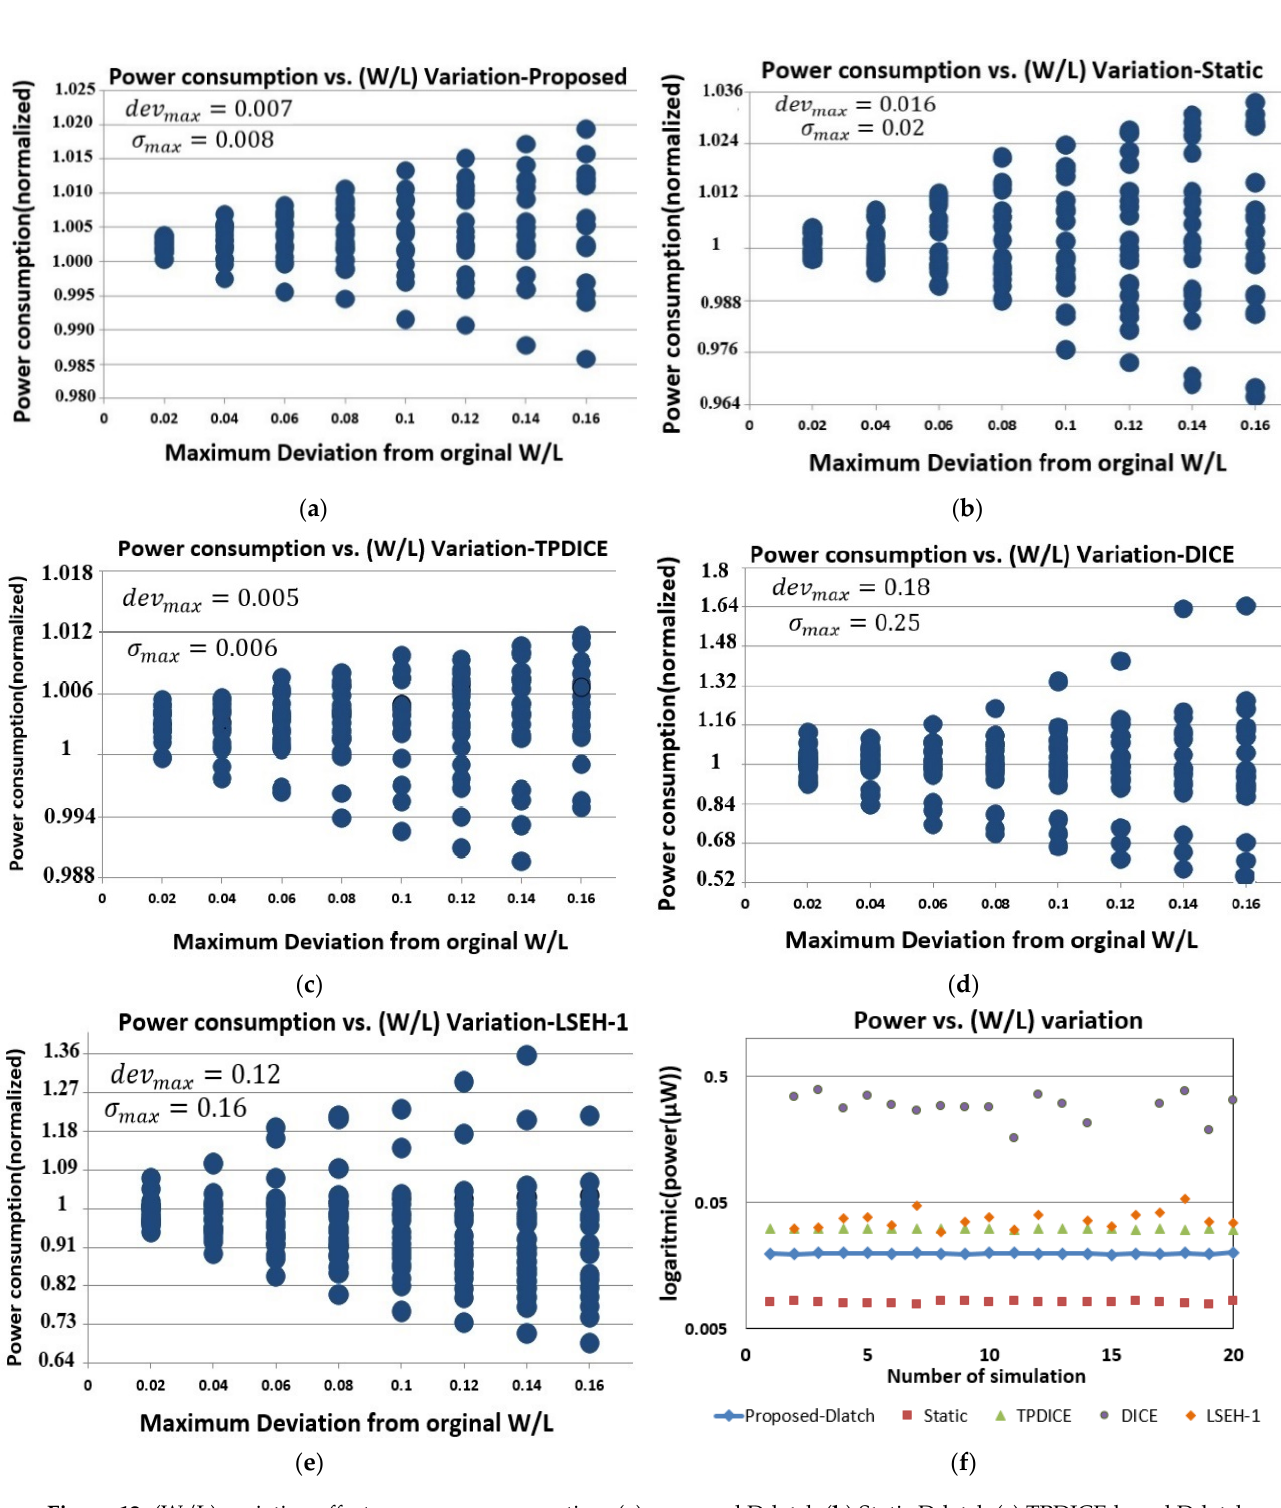
Figure 12. (W/L) variation effect on power consumption: ( a ) proposed D-latch ( b ) Static D-latch ( c ) TPDICE-based D-latch ( d ) DICE ( e ) LSEH-1 latch ( f ) power consumption of D-latches with maximum deviation, 0.16, from original W/L value.